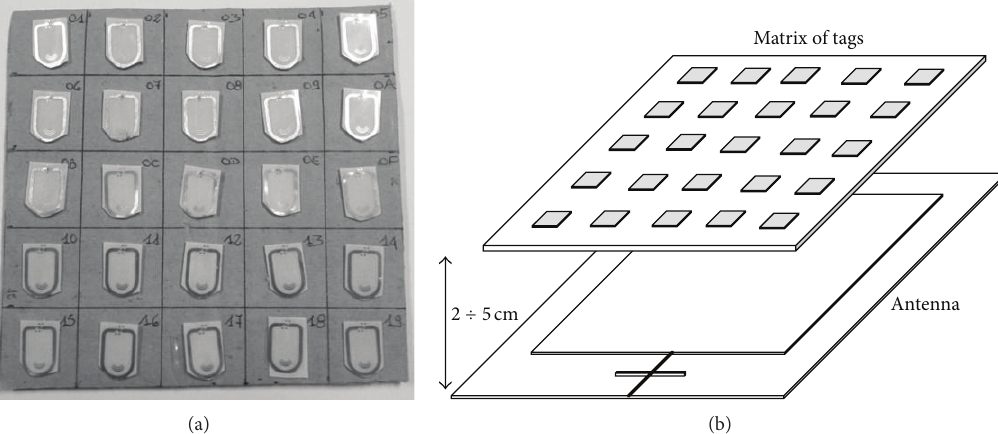
Figure 5: (a) A 5 × 5 matrix of RFID NF tags. (b) Schema used for both antenna/tag distance and reader power output evaluation.